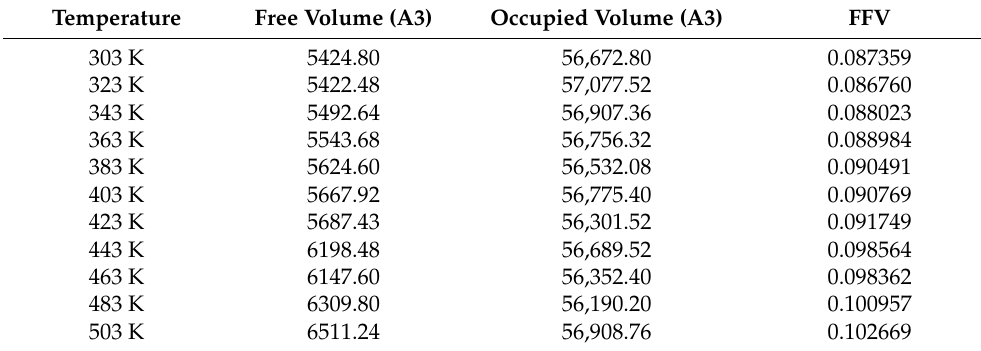
Table 2. Free volume of the KH792-modified nano-SiO 2 and cellulose composite